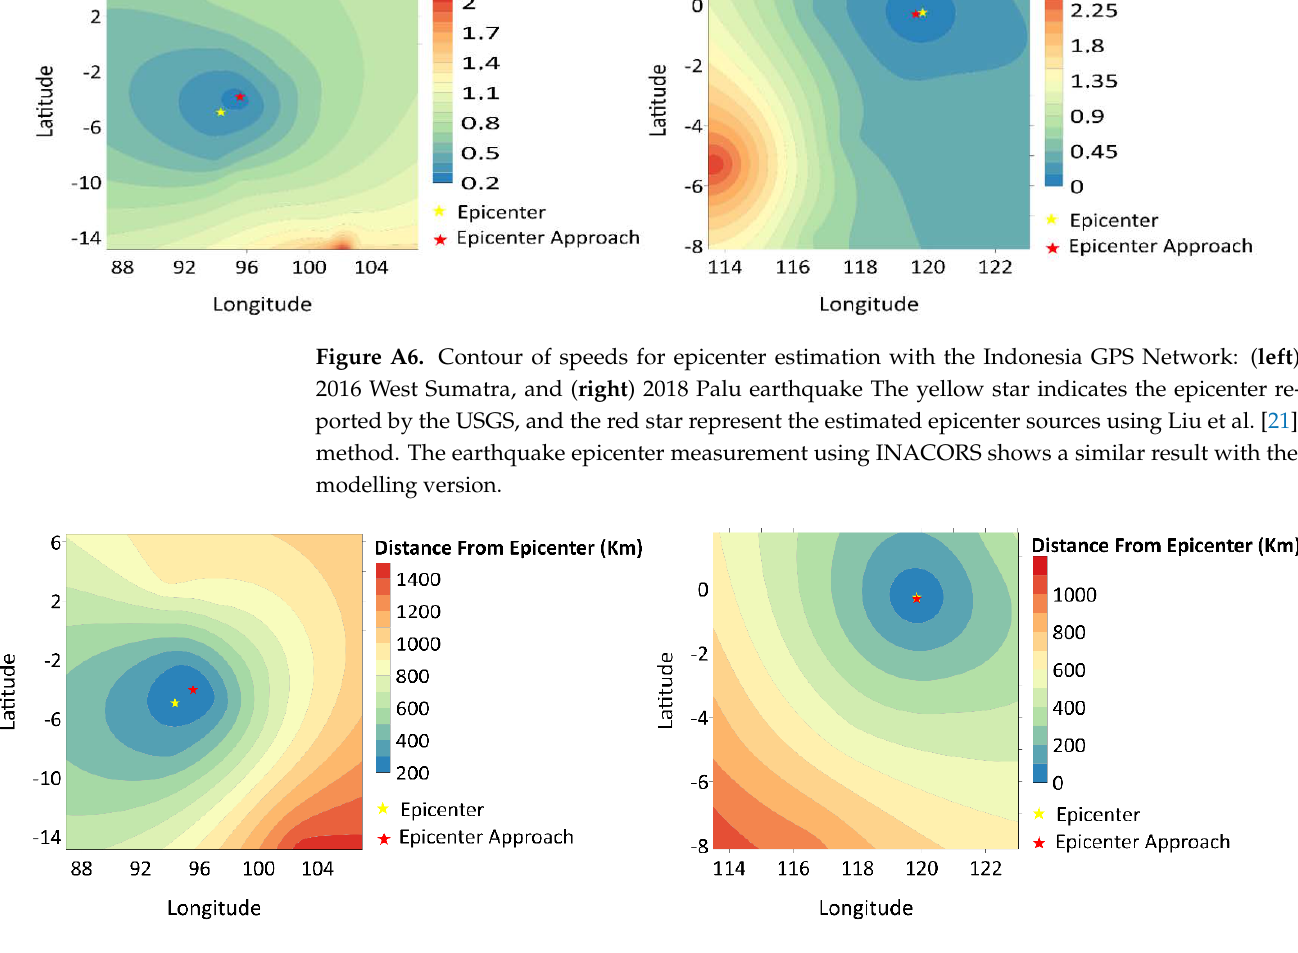
Figure A7. Contour of distance from epicenter estimation with the Indonesia GPS Network: ( left ) 2016 West Sumatra, and ( right ) 2018 Palu earthquake. The yellow star indicates the epicenter reported by the USGS, and the red star represents the estimated epicenter sources using Liu et al.’s [21] method. The earthquake epicenter measurement using INACORS shows a similar result with the modelling version.